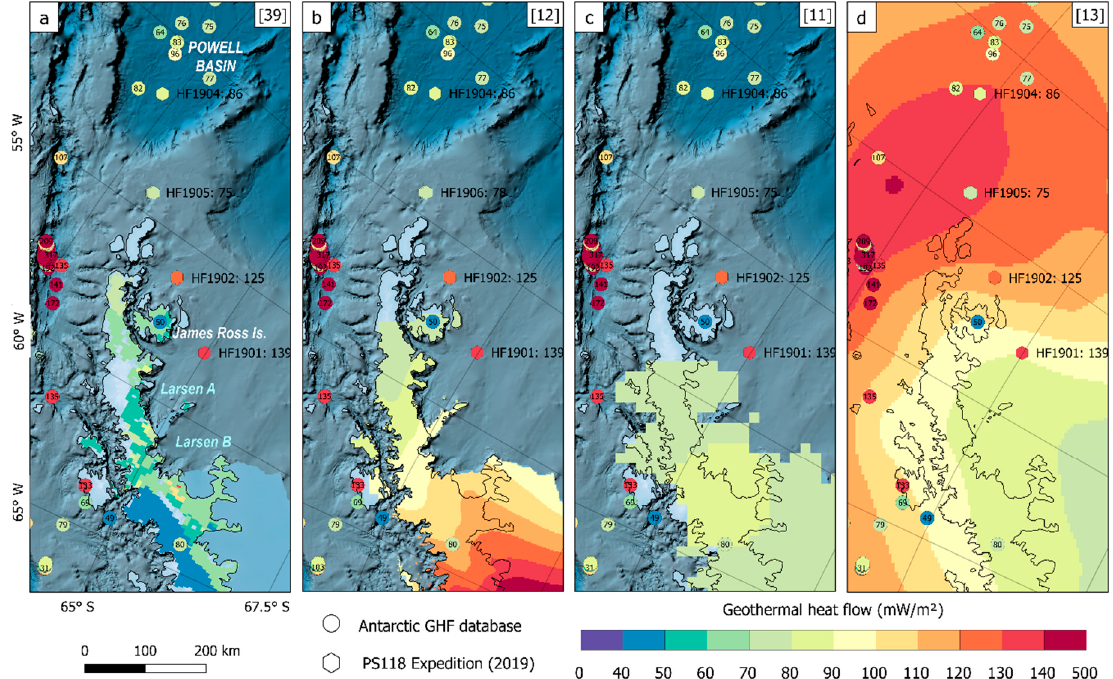
Figure 9. ( a ) GHF model derived from heterogeneous crustal heat production [39]. ( b ) Magnetically-derived GHF model [12]. ( c , d ) Seismically-derived GHF models [11,13]. In situ data from the Antarctic Geothermal Heat Flow database [42] marked with color-coded circles. In situ measurements from this study marked with color-coded hexagons. Bathymetric map from shows bed elevation from BedMachine Antarctica [6].